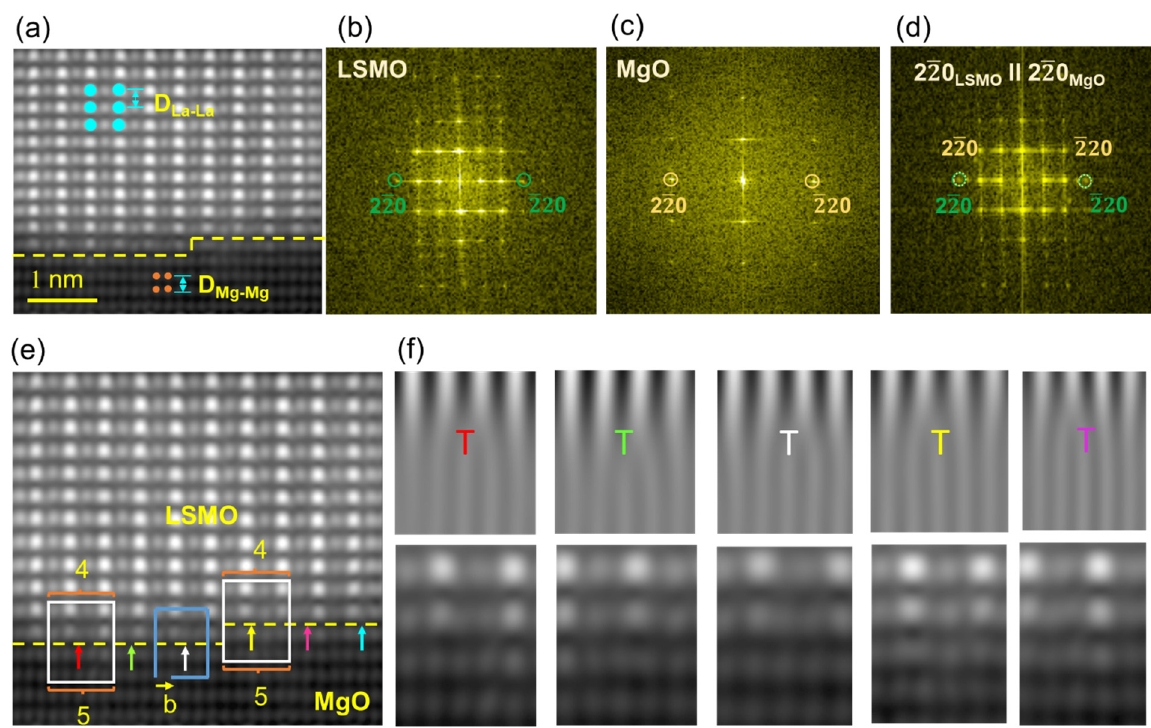
Figure 2. ( a ) HAADF image of LSMO over MgO showing the defined La-La and Mg-Mg bond length, ( b – d ) shows electron diffraction spots for the respective film, ( e ) HAADF image showing a 4/5 planes lattice matching and the dislocation periodicity, and ( f ) IFFTs along (110) with the magnified images of dislocation cores. Vertical arrows of different colors point to the extra-half planes at each dislocation core. The corresponding matching domains were bracketed with their sizes noted by the number of the LSMO and MgO lattice planes, respectively. A Burgers circuit is applied on a dislocation core to identify the Burgers vector along the edge